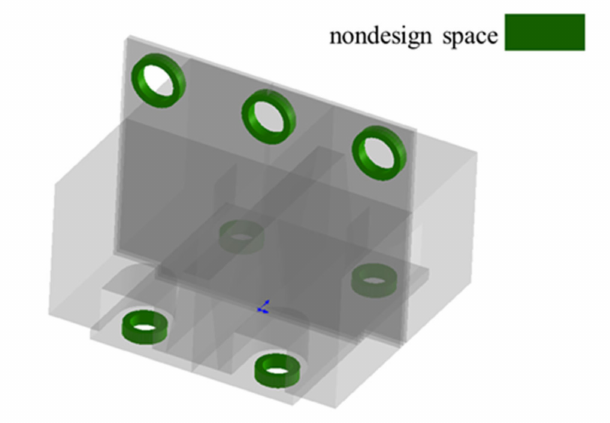
Figure 7. Schematic diagram of non-design